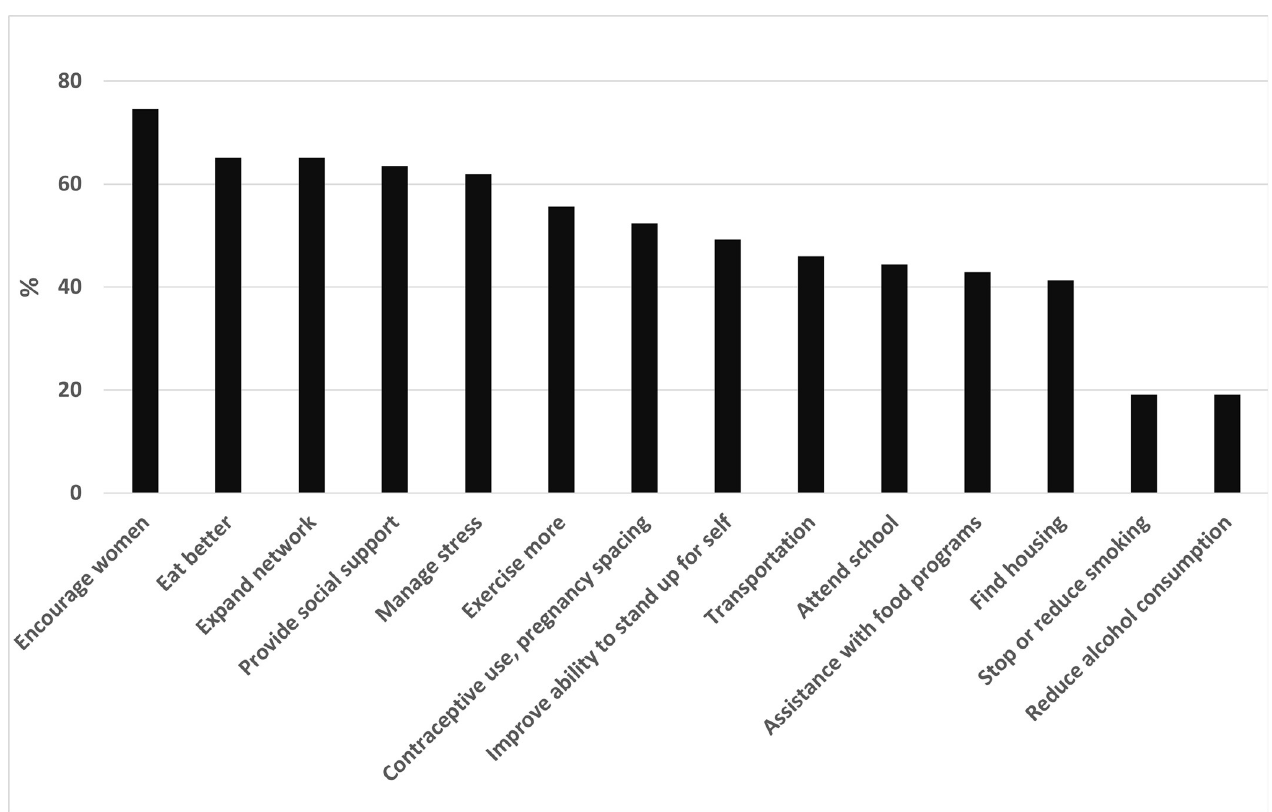
Fig 2. Summary of WIN Network participants’ views of how the program helped them with opportunities to thrive 2–3 years after participating.